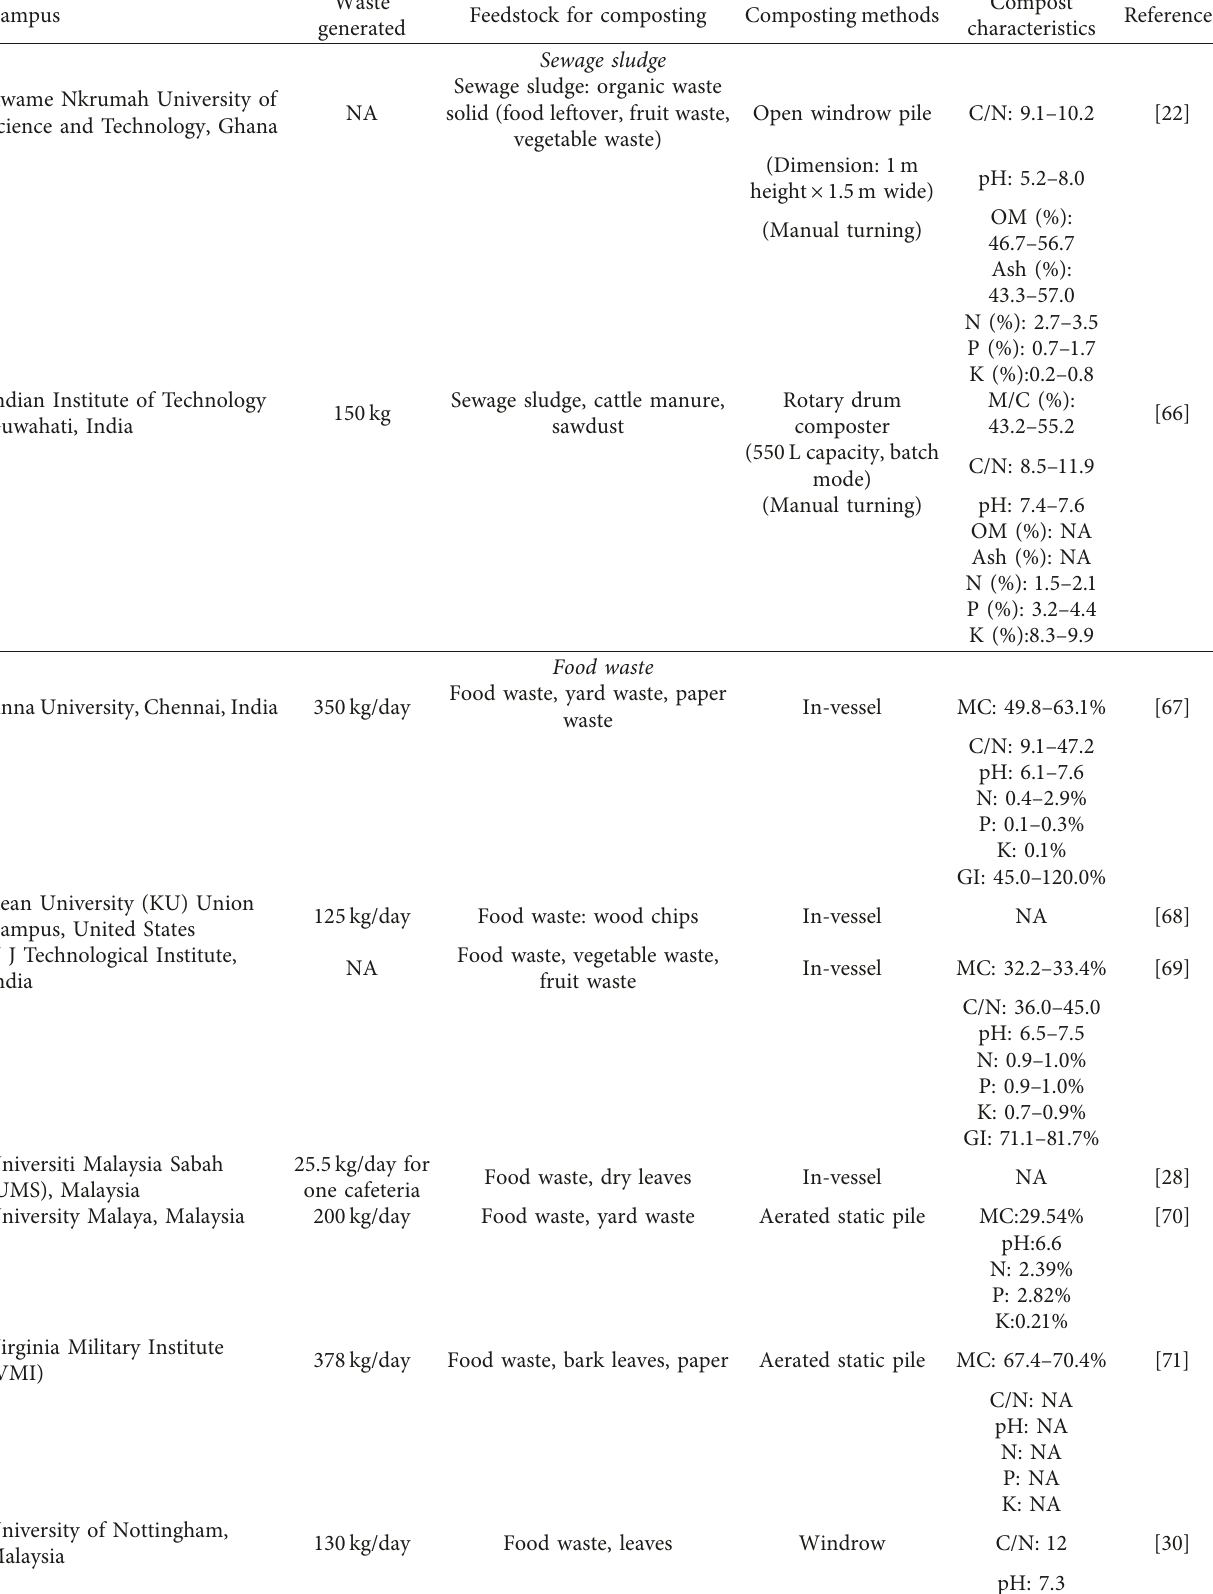
Table 2: Sewage sludge and food waste composting of some higher education